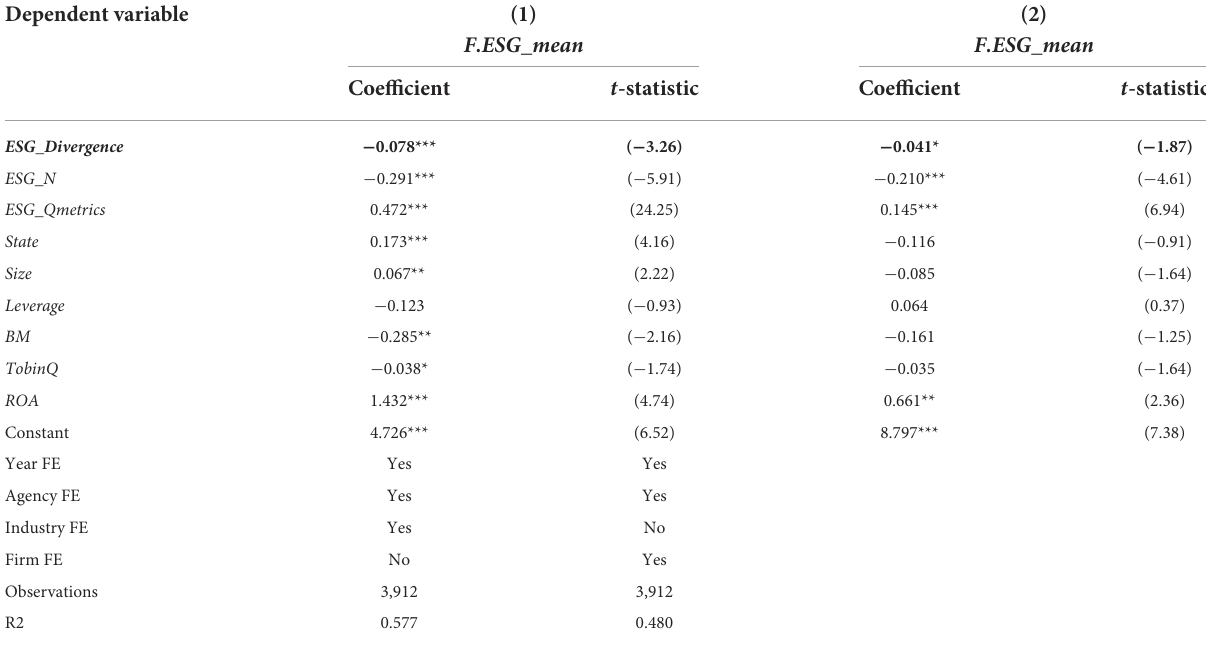
TABLE 6 Additional analyses: the consequence of ESG rating divergence on future